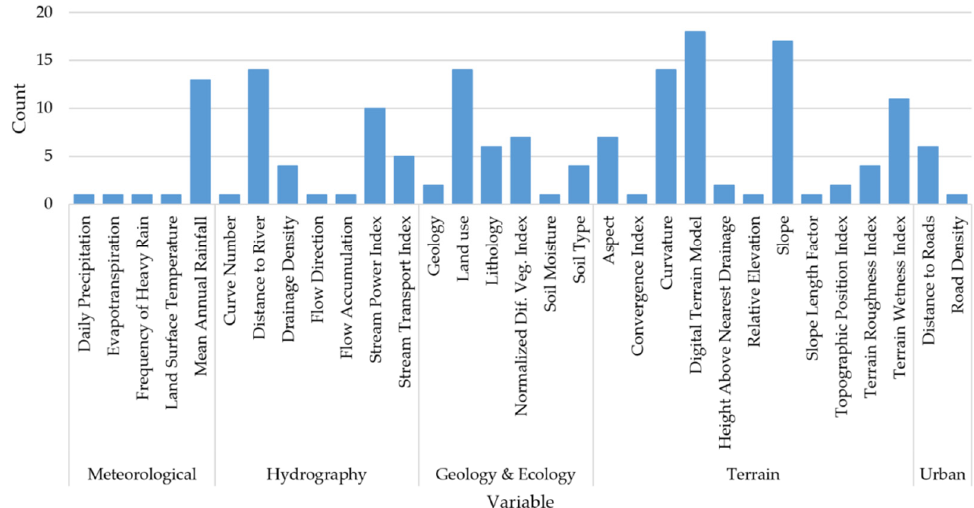
Figure 1. Frequency of variables used in flood susceptibility mapping summarized from literature review .